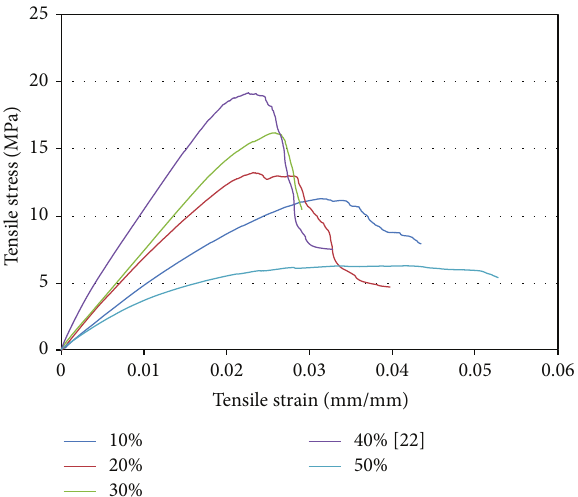
Figure 3: Average values of tensile stress-deformation diagram of different fiber content of kenaf/PVB composites.